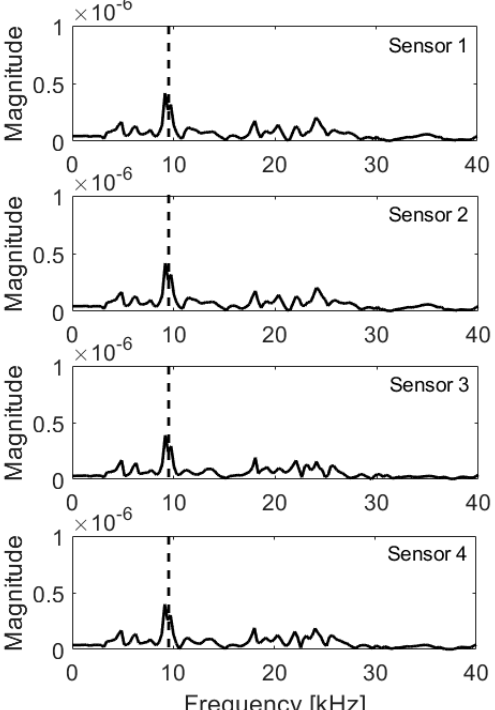
Figure 8. Frequency spectra, void below impactor; expected frequency marked with dashed line.